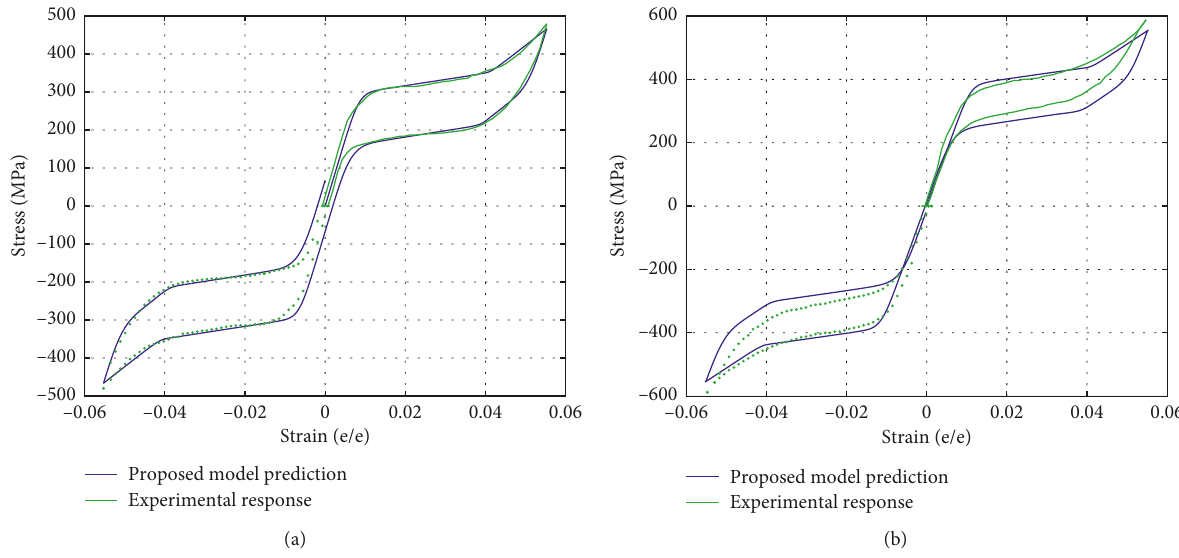
Figure 7: Comparison of the proposed model prediction to experimental response at frequencies (a) of 0.025 Hz and (b) of